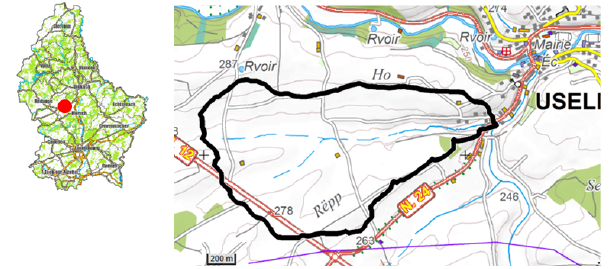
Fig. 6. Catchment area of the Wollefsbach catchment in Luxem- bourg. Left: red dot indicates the location in Luxembourg, right: topographic map of the Wollefsbach catchment with indicated the catchment boundary of the Wollefsbach catchment (source: http: